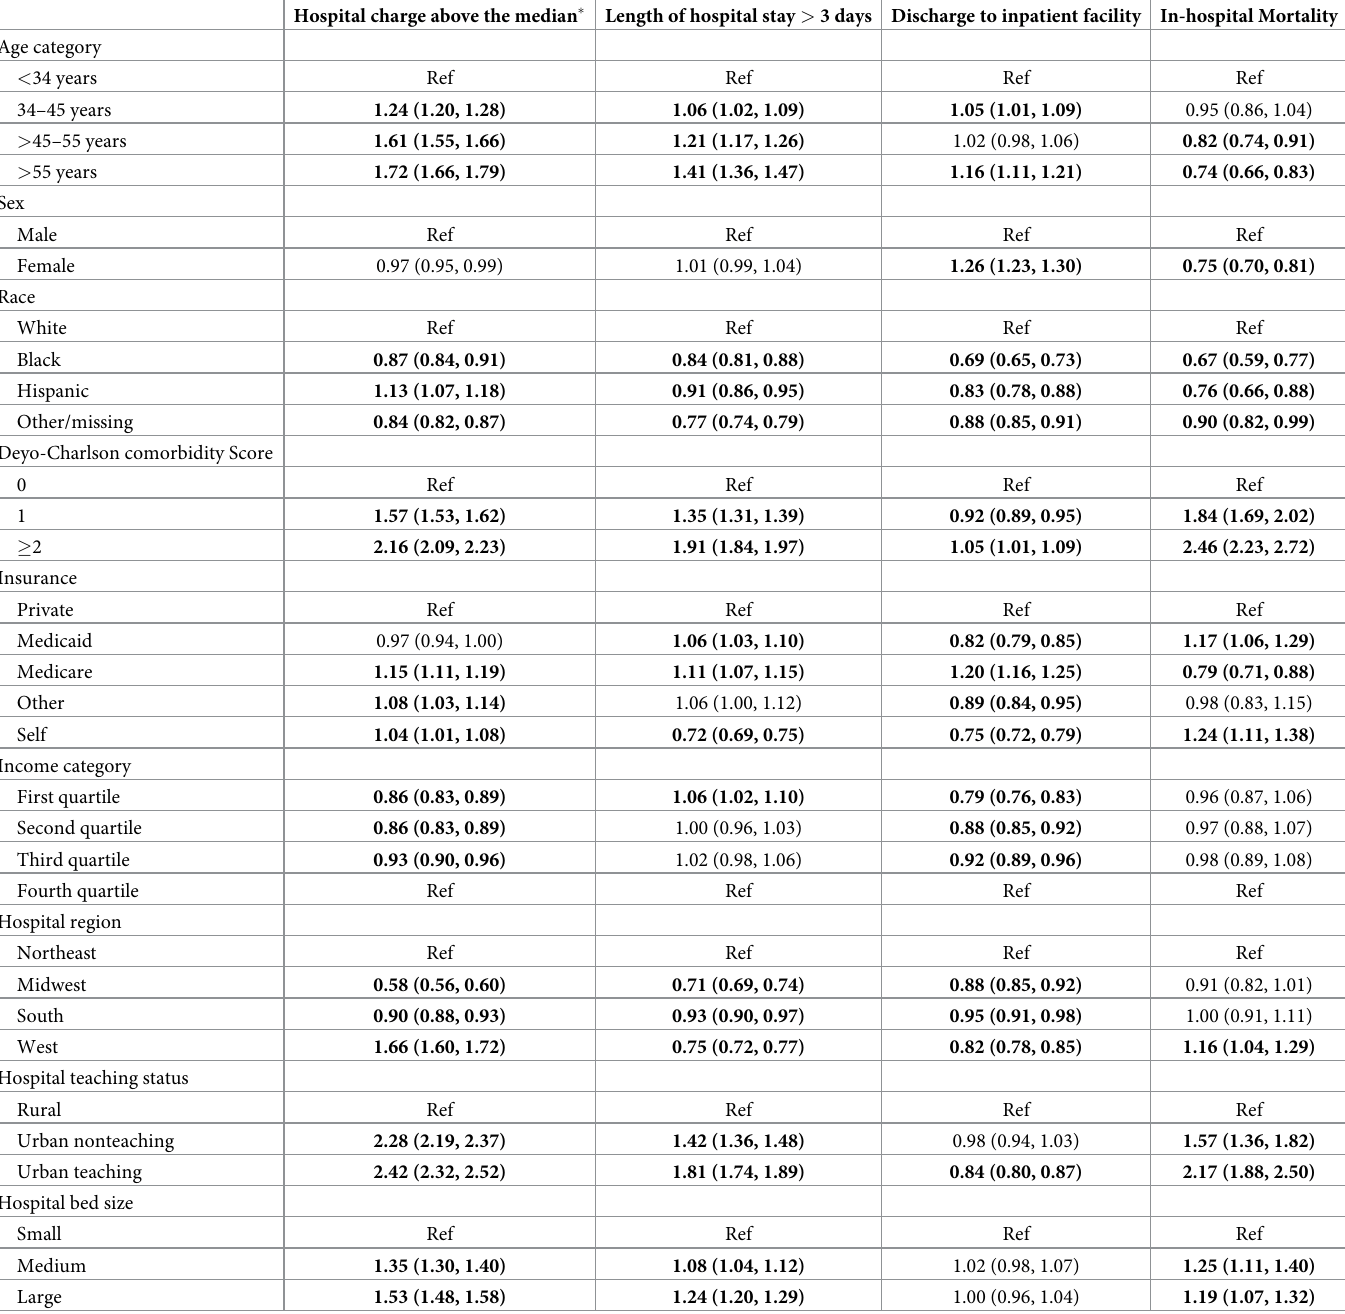
Table 5. Predictors of healthcare utilization for people with an OUD hospitalization in the